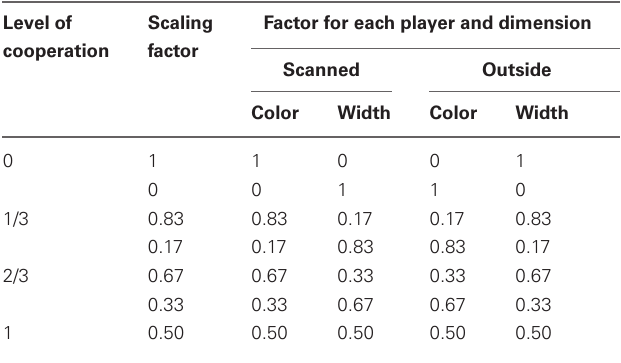
Table 1 | Level of cooperation scaling